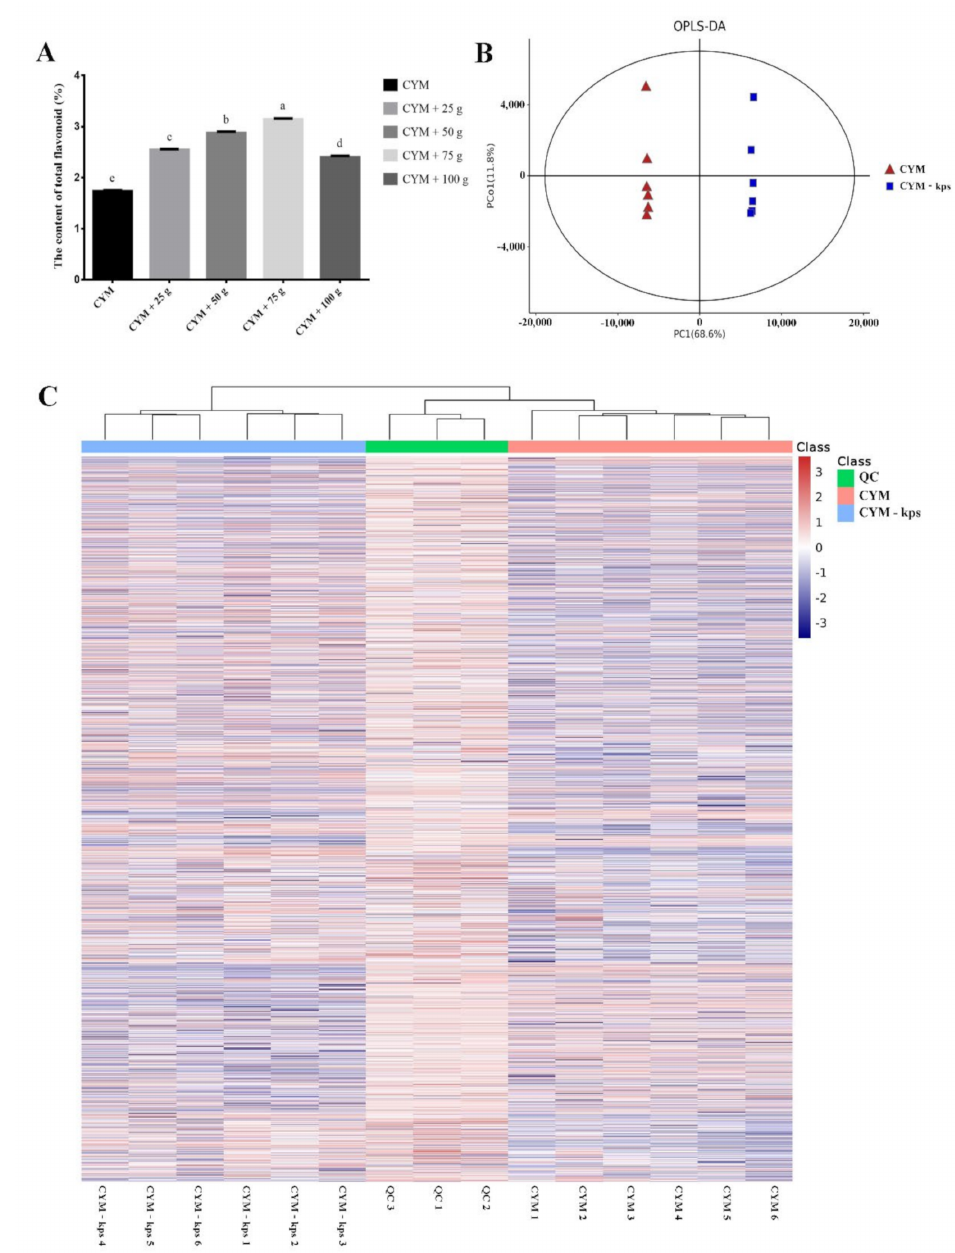
Figure 1. Qualitative metabolomics analysis of A. cornea. ( A ) the content of total flavonoid. Means within a column carrying the same letter are not significantly different. Different superscript lowercase letters (a, b, c, d, and e) indicate significant differences ( p < 0.05). CYM, complete yeast medium as control group; CYM + 25 g/L, CYM + 50 g/L, CYM + 75 g/L and CYM + 100 g/L, respectively, indicate CYM-kps medium with C. korshinskii leachate concentrations of 25 g/L, 50 g/L, 75 g/L and 100 g/L. ( B ) OPLS-DA analysis between different samples. ( C ) a hierarchical heatmap clustering analysis of the samples. QC, quality control sample; the QC sample was generated from a mixture of equivalent quantities of the 12 samples in this study. CYM, the metabolites of mycelia growth in the complete yeast medium. CYM-kps, the metabolites of mycelia growth in the CYM medium with C. korshinskii leachate concentration of 75